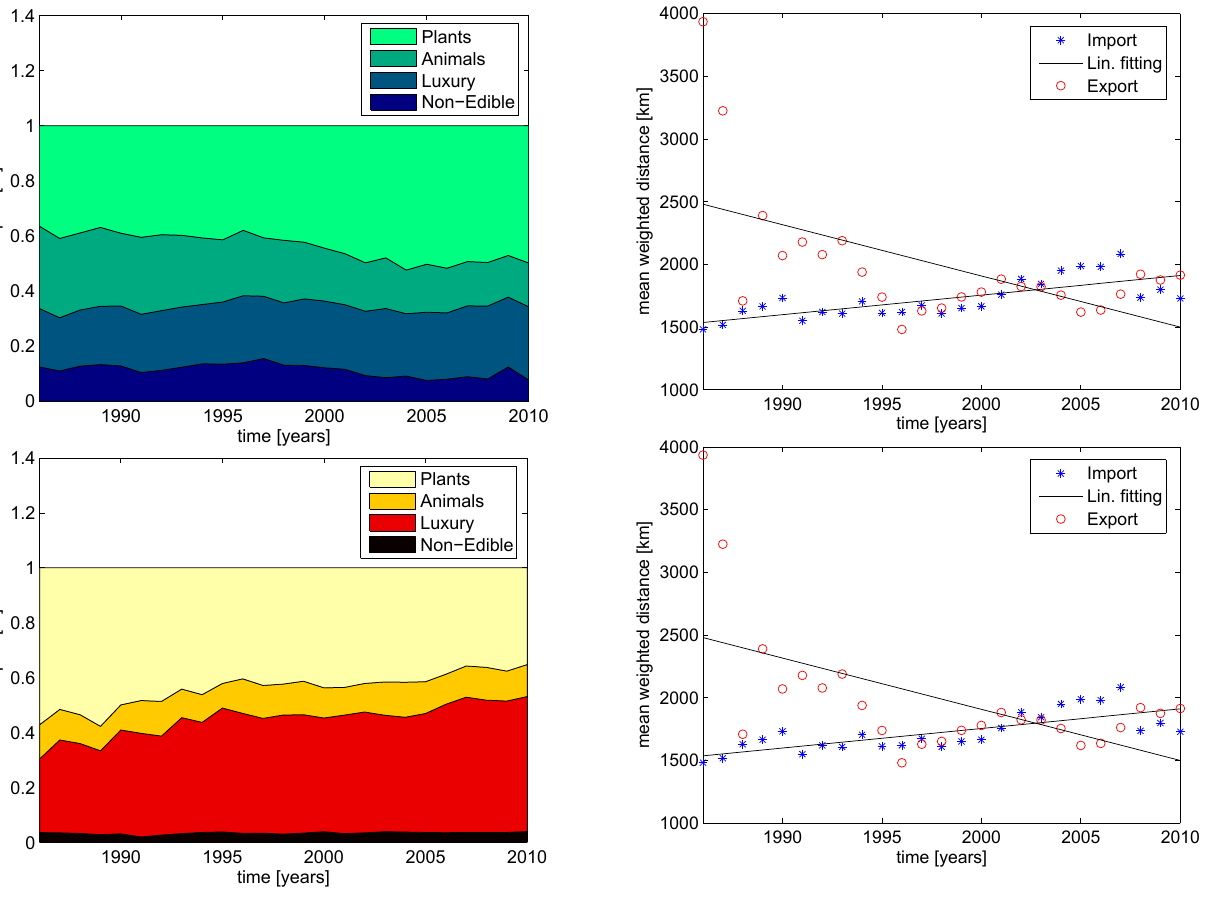
Fig. 8. Contributions of each category to the total volume of virtual water imported (upper panel) and exported (bottom panel) in the period 1986–2010.